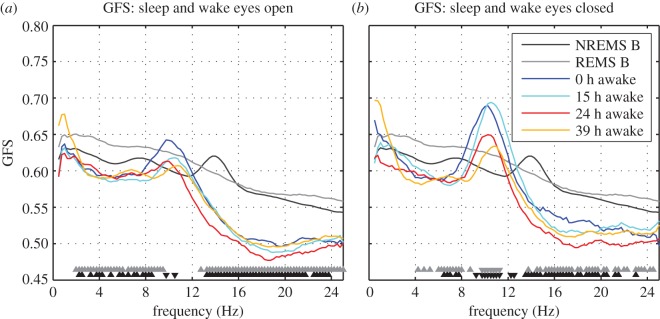
Subject average GFS spectra (smoothed, 9-point moving average; only for visualization purposes) of NREM, REM sleep and four different ‘doses’ of wakefulness. Eyes open waking GFS spectra shown in (a) and eyes closed in (b). Bootstrap statistics were used to compare NREM (significant bins shown in black triangles) and REM sleep (significant bins shown in grey triangles) with 15 h of wakefulness. The direction of the triangle shows the direction of the effect—up: sleep > waking and down: waking > sleep.